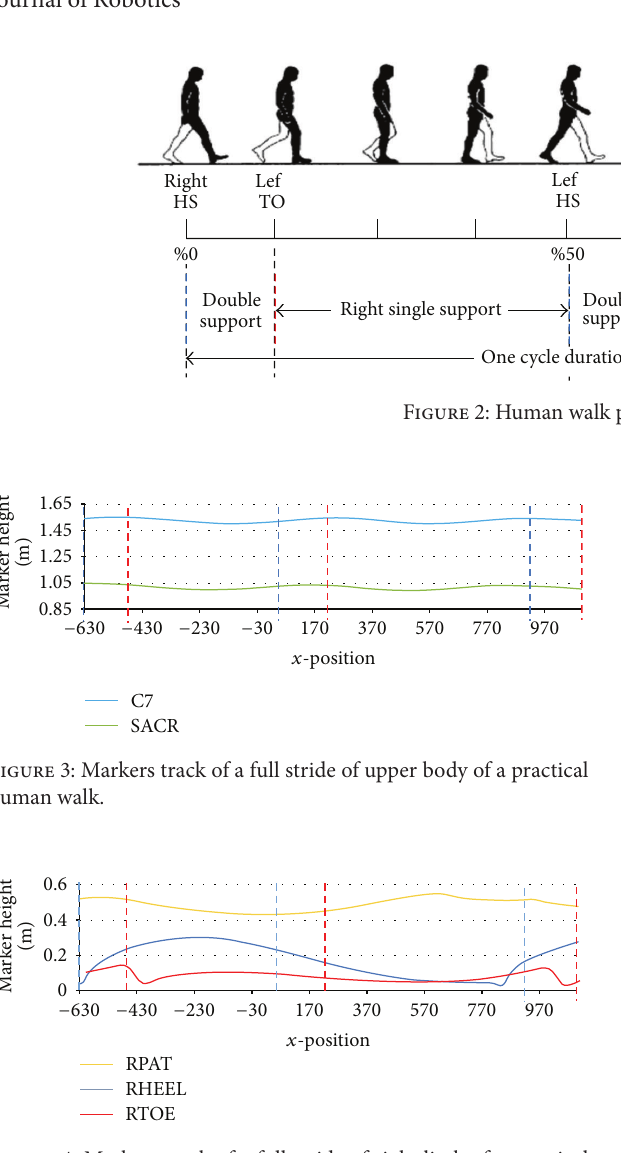
Figure 4: Markers track of a full stride of right limb of a practical human walk, for the patella (RPAT), the heel (RHEEL), and the toe